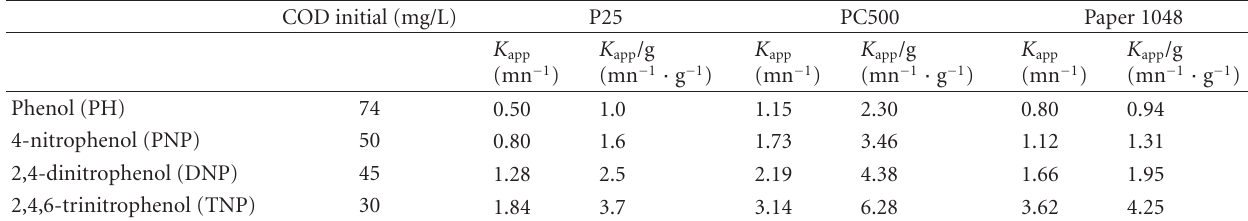
Table 4: Initial COD values in mgO 2 /L for nitrophenols having the same initial ponderal concentration (30mg/L). Apparent first-order rate constant K app and corresponding specific one K app / g cat .